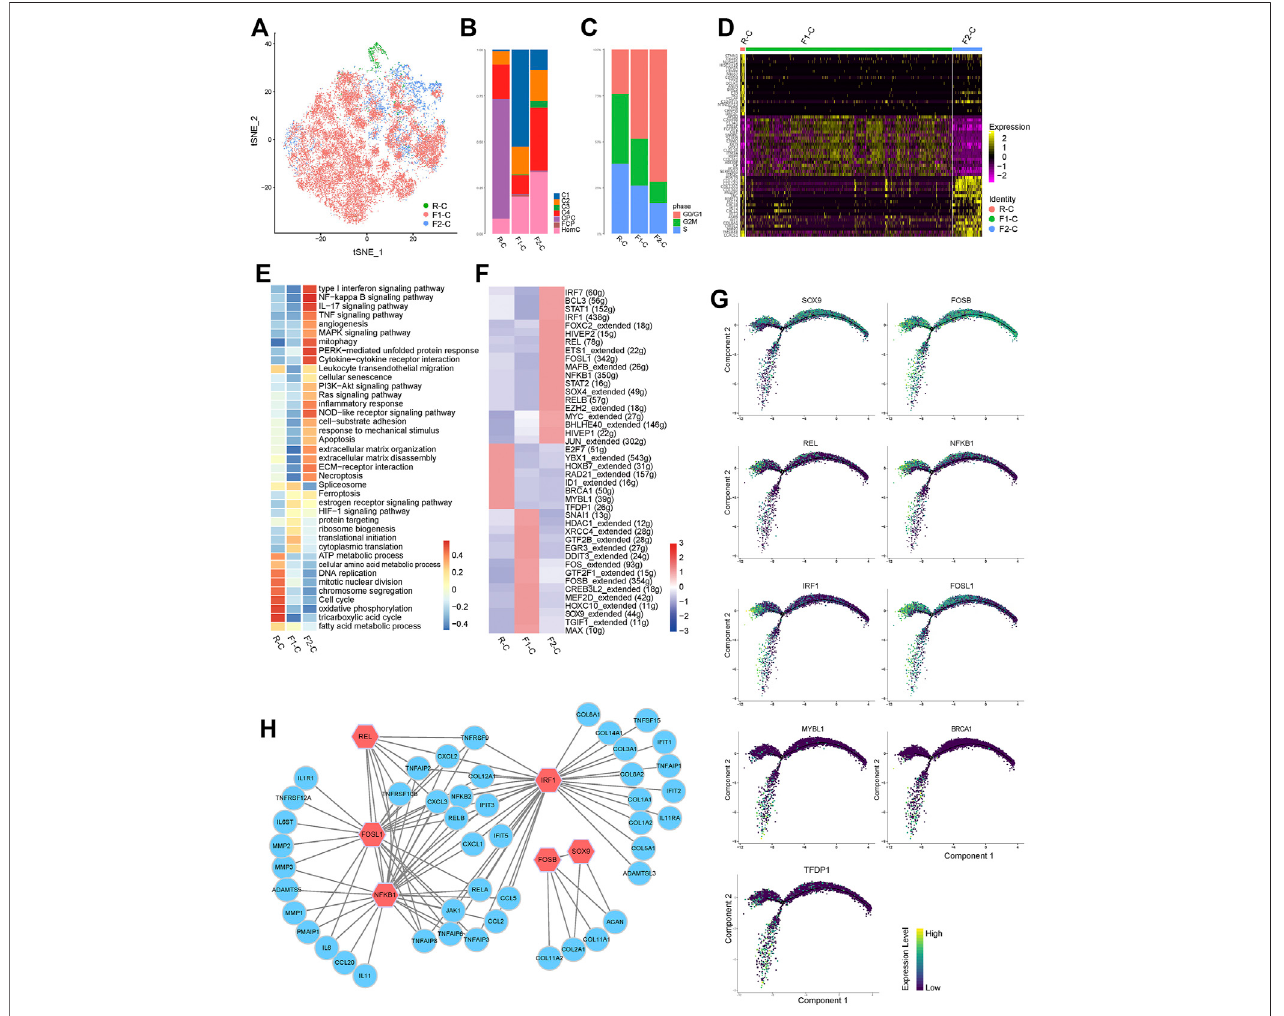
FIGURE5| Transcriptionalregulationrelated tochondrocytedifferentiation fate. (A) t-SNEofthechondrocytes pro fi ledthreecellstates (R-C,F1-C,andF2-C). (B) Bar plots represented the proportion of seven chondrocyte subclusters in R-C, F1-C, and F2-C. (C) Bar plots represented the proportion of cells annotated as the different cell cycle phases in R-C, F1-C, and F2-C. (D) Heatmap showing top 20 DEGs for R-C, F1-C, and F2-C; each column represents a cell state, and each row represents a DEG for a state. (E) The heatmap of GSVA of the GO and KEGG gene sets related to IVDD among the three cell states. (F) Heatmap indicating the expression regulation by TFs analyzed with SCENIC in three cell states. Numbers between brackets indicate the (extended) regulons for respective TFs. (G) The expressionlevelsoftheselectedTFsonpseudotimetrajectories. (H) RegulatorynetworksconsistingofselectedTFsandtheirtargetgenesdrivecellfatedifferentiation.A node represents a gene and edges represent the interactions. Red nodes are hub TFs. CPC, cartilage progenitor cells; FCP, fi brochondrocyte progenitors; HomC, homeostatic chondrocytes; DEGs, differentially expressed genes; TFs, transcription factors; SCENIC, single-cell regulatory network inference and clustering.